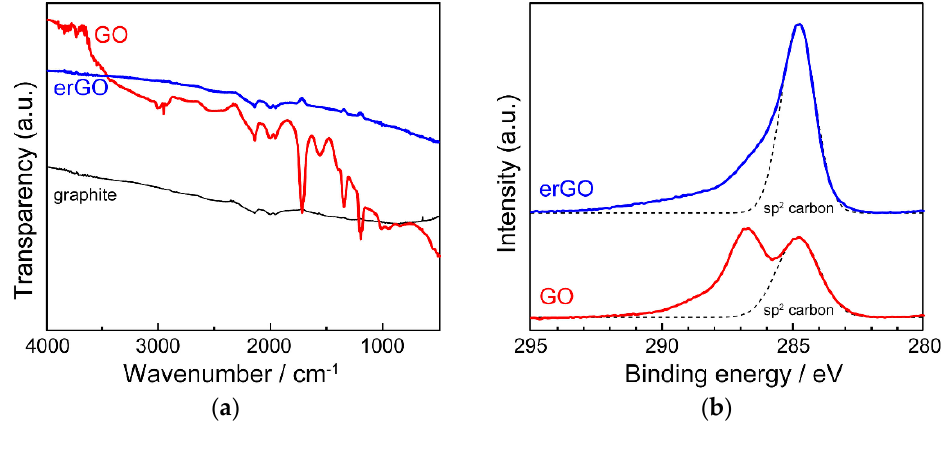
Figure 4. ( a ) FT-IR and ( b ) XPS spectra of erGO.